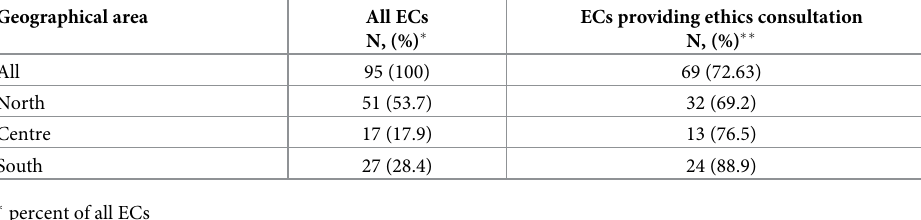
Table 3. Ethics committee policy concerning ethics consultation, by geographic area.